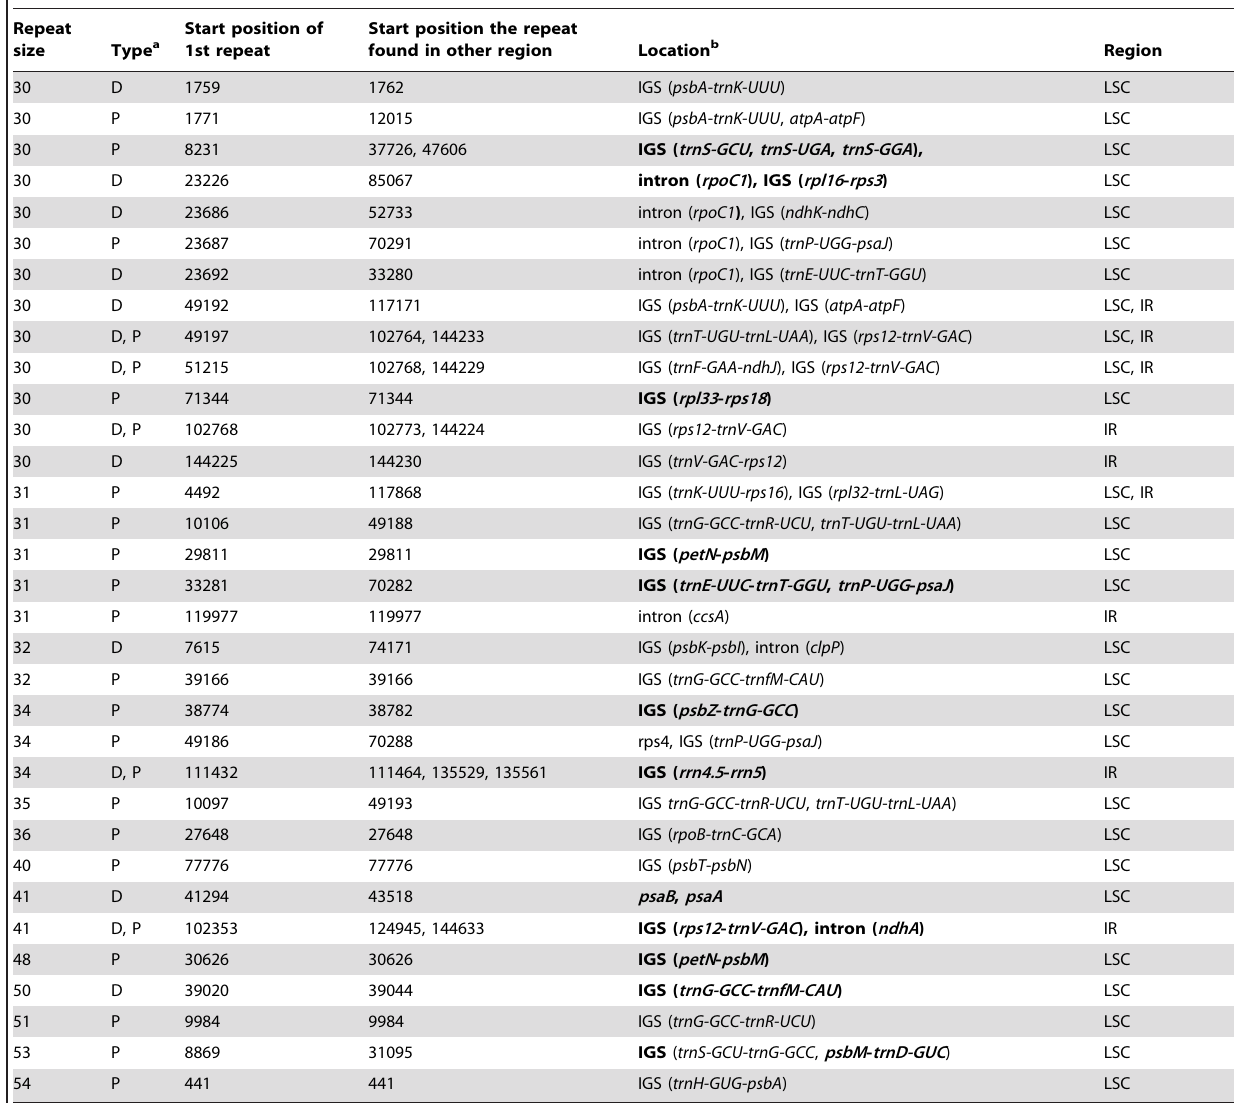
Table 4. List of long repeat